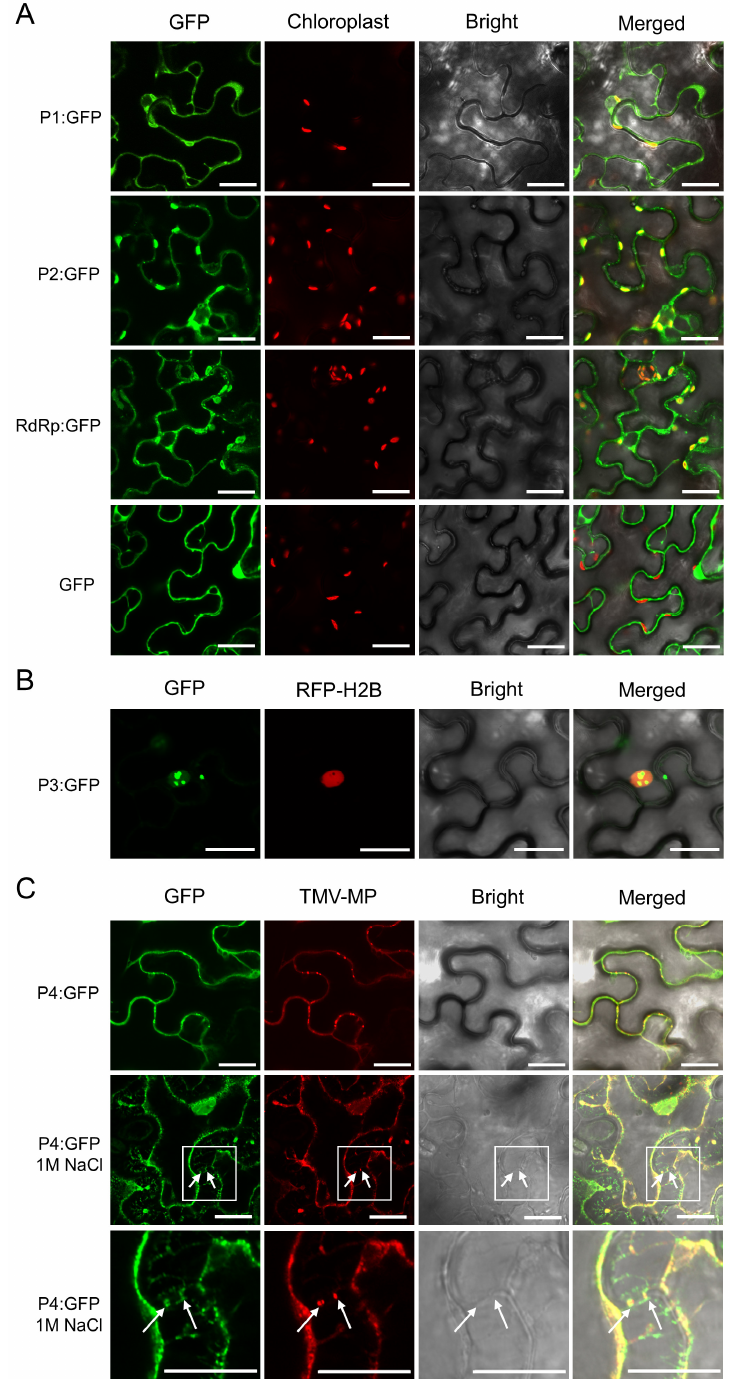
Figure 4. Subcellular localization of viral proteins of PSCYV was observed with confocal microscopy. ( A ) Subcellular localization of PSCYV P1, P2, and RdRp in infiltrated N. benthamiana leaves (green). Red signal represents chloroplast. ( B ) Subcellular localization of PSCYV P3 in infiltrated N. benthami- ana leaves (green). Red signal represents nucleus. ( C ) Colocalization of PSCYV P4 and TMV MP-RFP in co-infiltrated N. benthamiana leaves. The infiltrated N. benthamiana leaves were treated with 1 M NaCl at 2 dpi. Red signal represents the subcellular localization of TMV-MP. White arrows indicate PD position. The bottom row is the enlarged image of the boxed area in the middle image. Scale bars, 20 µ